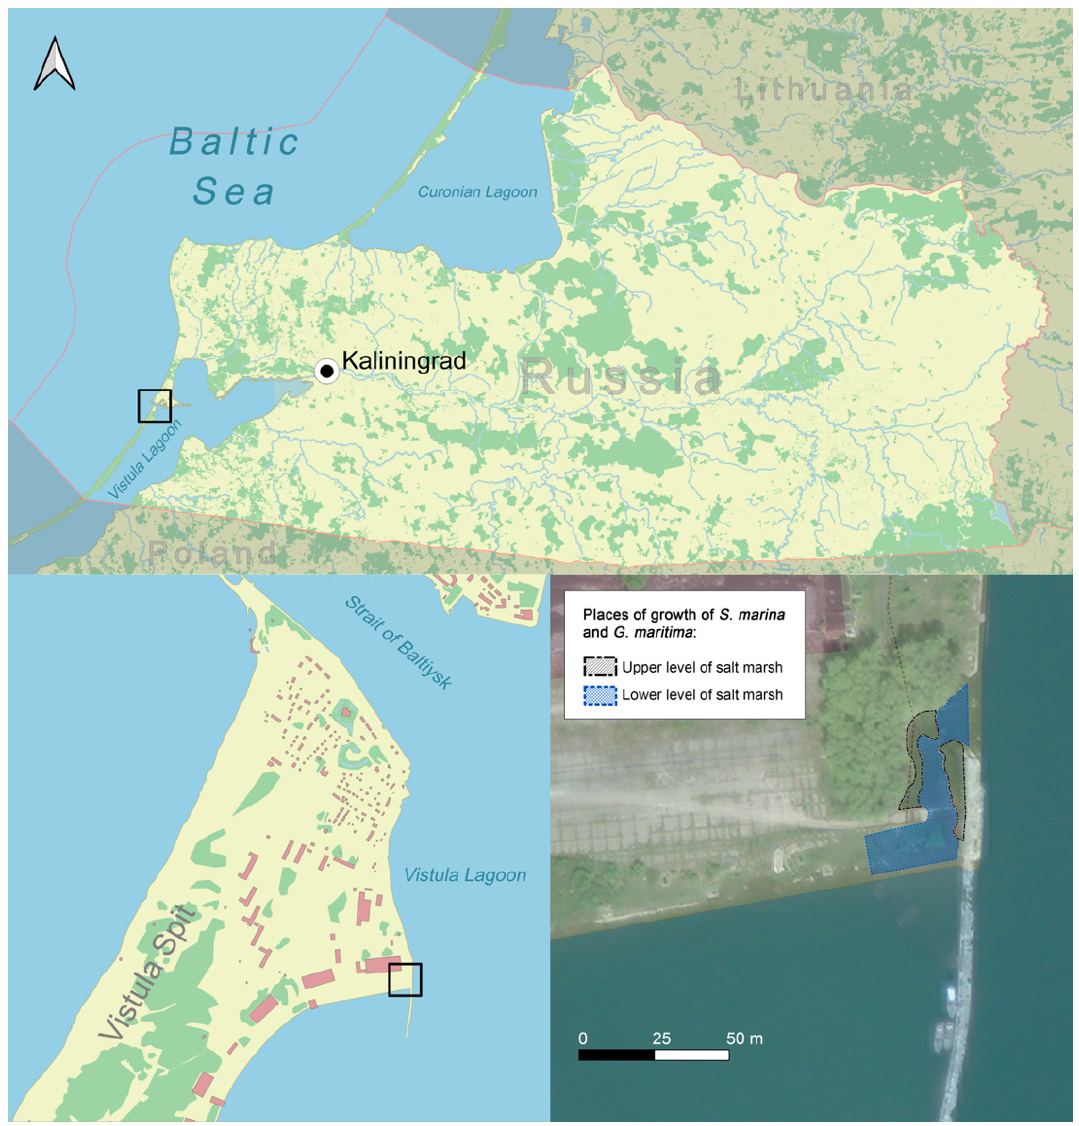
Figure 5. Map showing the growth sites of S. marina and G. maritima.